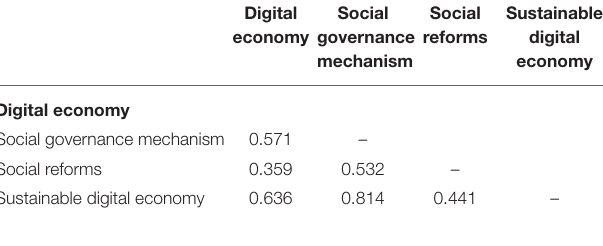
TABLE 4 | HTMT ratio.